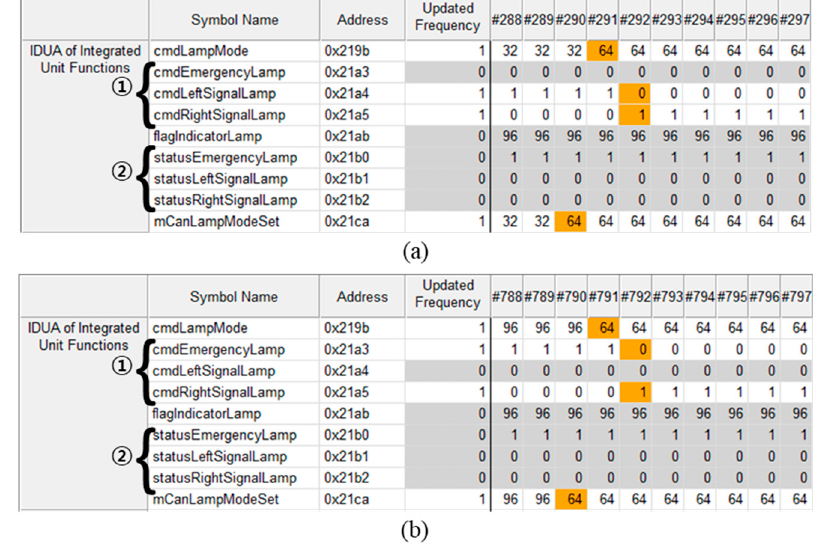
Figure 11. The Fault Candidates of the Fault Index #1: ( a ) Switching “Left Turn Signal” into “Right Turn Signal” (MUI IDUA of Unit Function, IDUR); ( b ) Switching “Emergency Signal” into “Right Turn Signal” (MUI IDUA of Unit Function, IDUR).